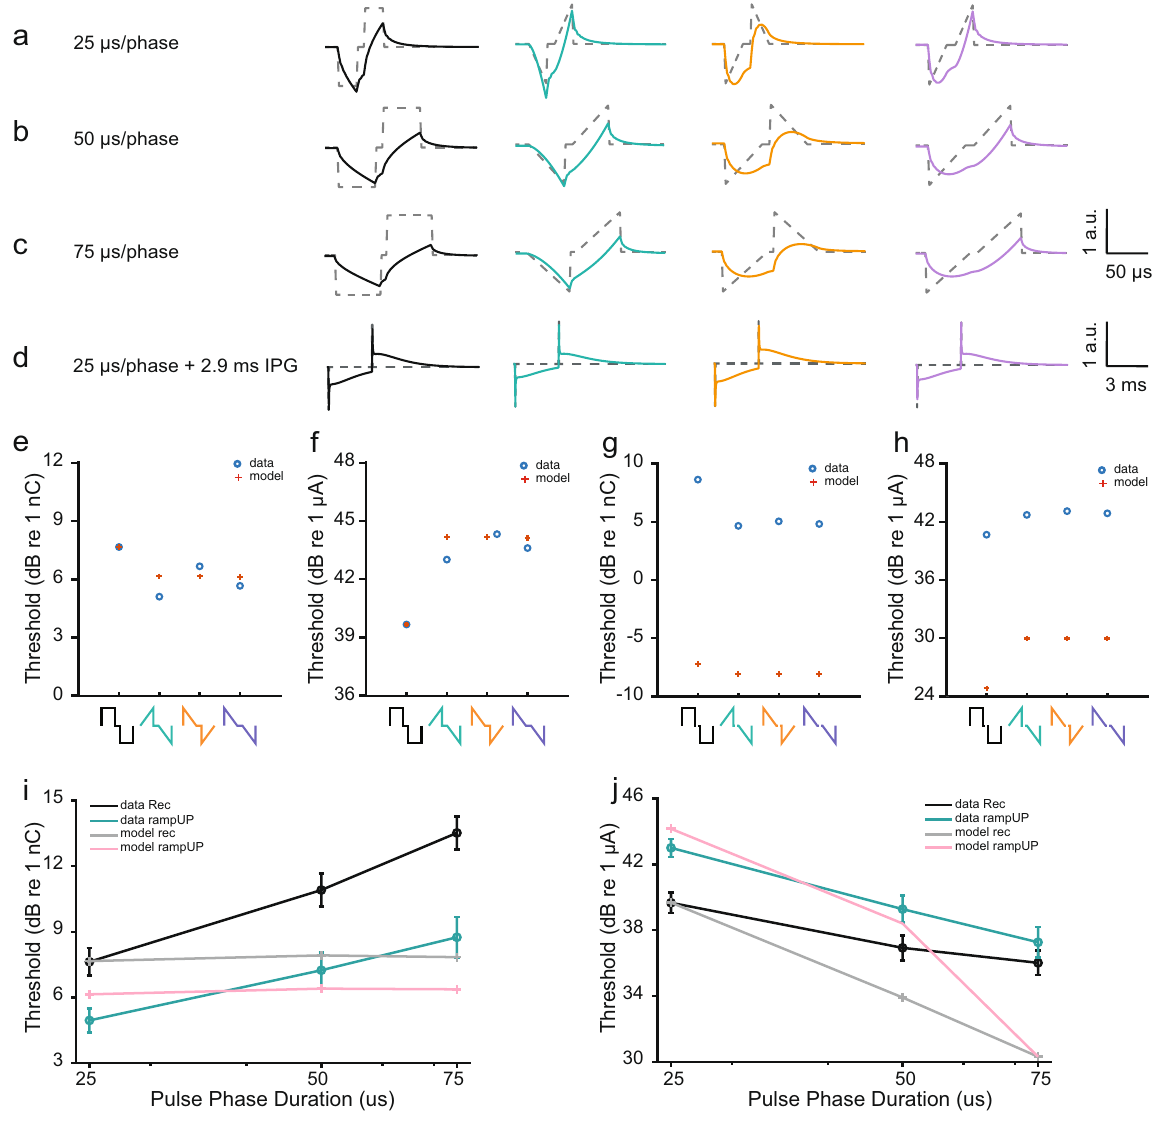
Figure 7. Comparison of measured wave II thresholds and predicted thresholds from the lowpass filter model. ( a–d ) Input waveform (dashed, grey) and the filtered signal (solid, color) plotted on top for phase durations of ( a ) 25 µ s ( b ) 50 µ s and ( c ) 75 µ s and ( d ) an interpulse gap of 2.9 ms with Rec (black), rampUP (green) rampDOWN (orange) and rampLONG (purple). Note the input level has an arbitrary unit. Only cathodic-first polarity is shown. ( e,f ) Threshold in charge ( e ) and current ( f ) from the mouse data (averaged across polarity and across mice) of wave II (blue circle) and model predictions (red cross) with 25 µ s/phase and an interpulse gap of 10 µ s for all four waveforms. n = 12. ( g,h ) Threshold in current ( g ) and charge ( h ) from mouse data (averaged across polarity and of 1 st and 2 nd phase, across mice) of wave II (blue circle) and model predictions (red cross) with 25 µ s/phase and an interpulse gap of 2.9 ms for all four waveforms. n = 6. ( i,j ) Threshold in current ( j ) and charge ( j ) from the mouse data (averaged across polarity and across mice) of wave II (black; Rec, green; rampUP) and model predictions (grey; Rec, pink; rampUP) as a function of phase durations. n = 12 for 25 µ s/phase and 50 µ s/phase, n = 9 for 75 µ s/phase. Error bars are